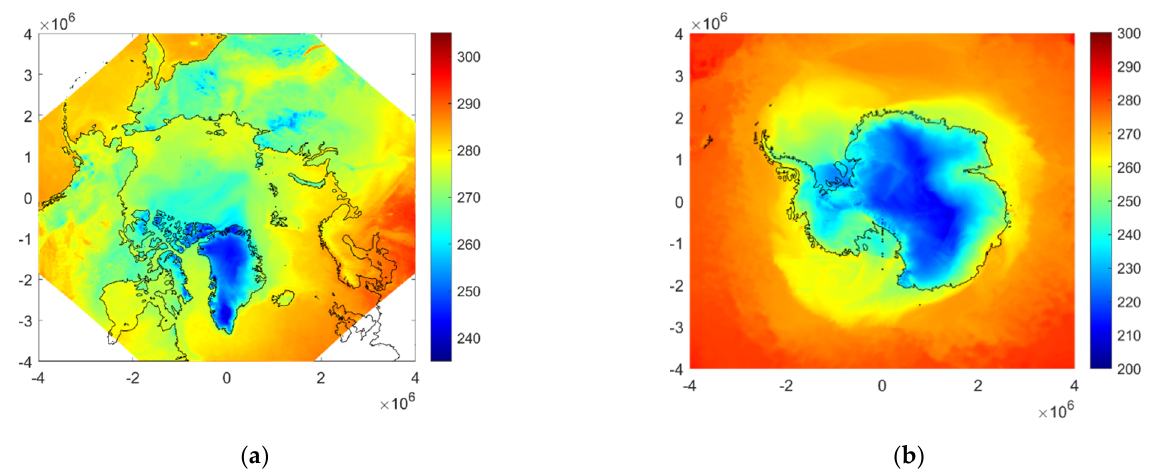
Figure 4. Skin surface temperature (K) maps from: ( a ) Arctic, October 3; and ( b ) Antarctic, October 9.